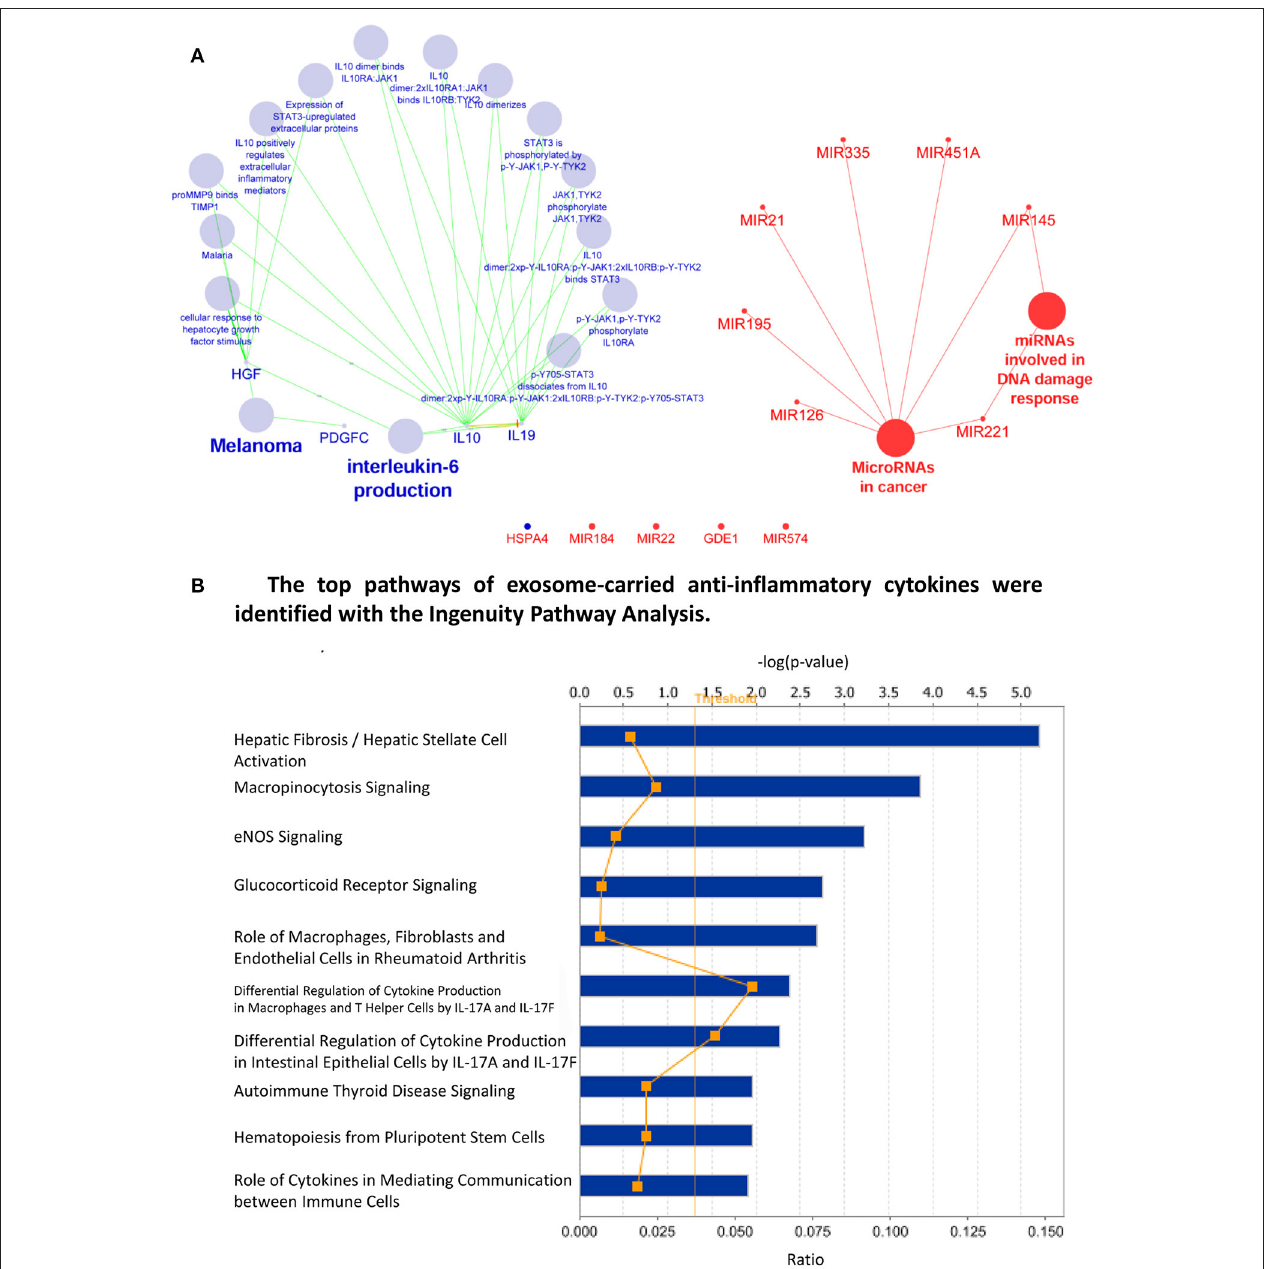
FIGURE 9 | anti-inflammatory cytokines and miRNA found in immune cell derived exosomes have distinct cellular networks. (A) Cytoscape Network Visualization Analysis revealed that miRNA (red) and anti-inflammatory cytokine (green) have distinct cellular networks that are not shared (large spheres represent biological processes while small sphere indicates a gene/mRNA). (B) The major pathways that are regulated by the anti-inflammatory cytokines carried in exosomes derived from immune cells.